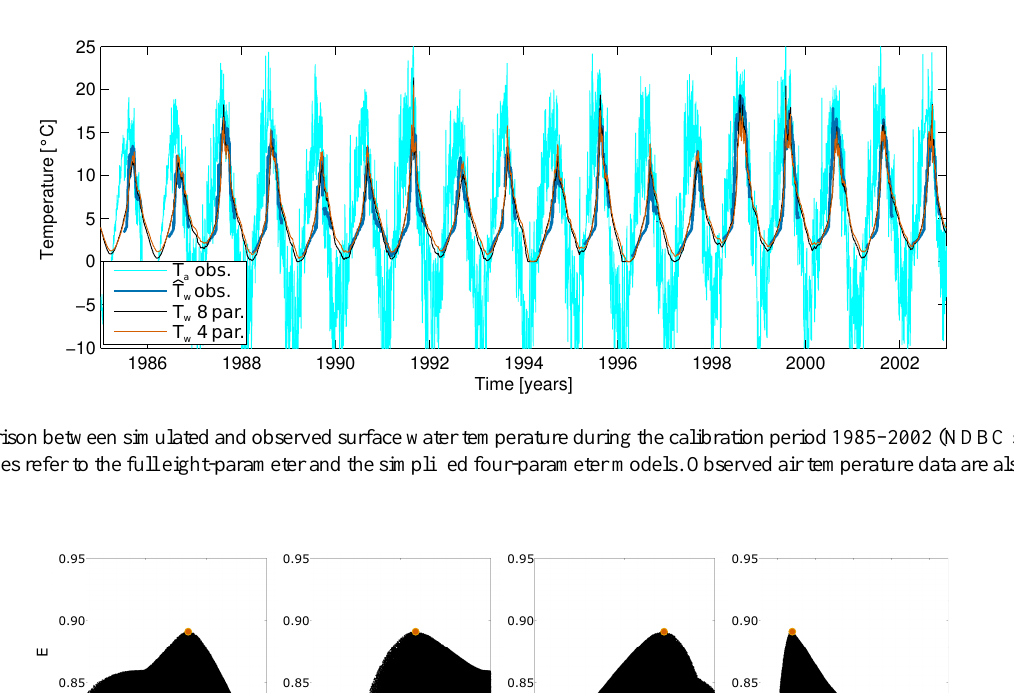
Fig. 7. Comparison between simulated and observed surface water temperature during the validation period 2003-2011 (NDBC simulation). Simulated curves refer to the full 8-parameter and the simplified 4-parameter models, respectively. Observed air temperature data are also presented with cyan line.